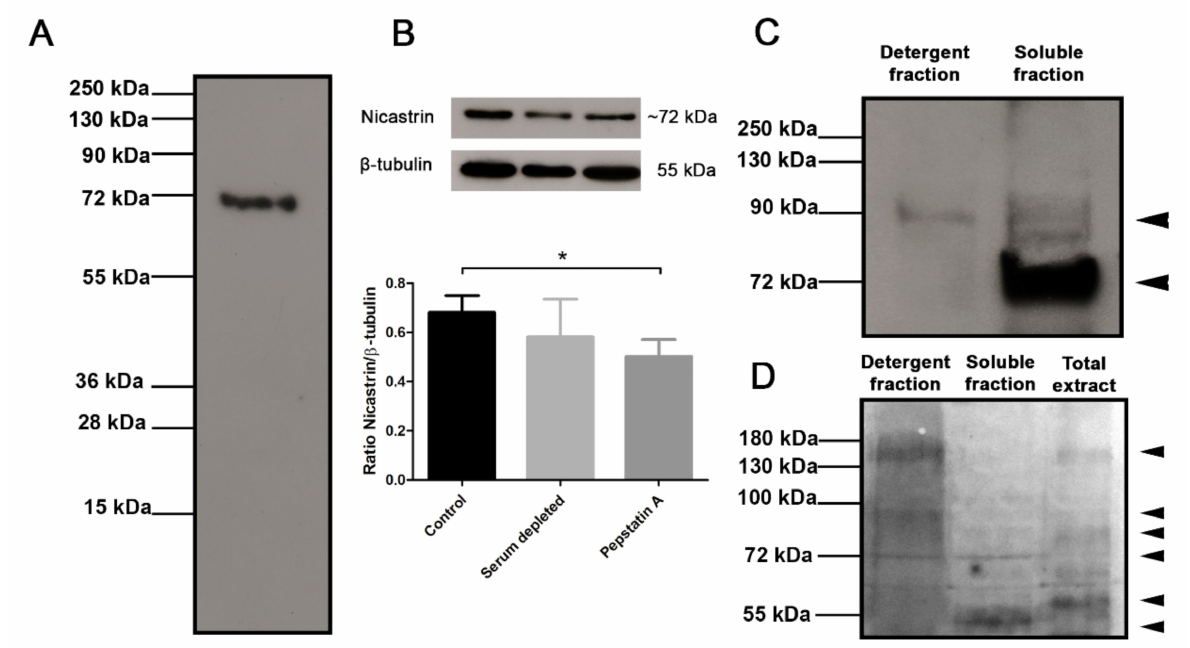
Figure 2. Immunoblot analysis of anti-Tc/NICT-1 rabbit polyclonal serum for detection of the T. cruzi nicastrin-like protein. ( A ) The whole extract (20 µ g) probed with anti-Tc/NICT-1 serum identified a band with ~72 kDa. ( B ) Whole-cell extracts (20 µ g) from epimastigotes cultured 24 h under serum deprivation (BHI medium without FBS) and after treatment with gamma-secretase inhibitor pepstatin A (50 µ g/mL) probed with polyclonal anti-Tc/NICT-1 serum or anti- β -tubulin antibodies (internal control). The corresponding densitometry presents the ratio of T. cruzi NICT-like protein and β -tubulin. Data represent the mean and standard deviation from at least three independent experiments. ( C ) Membrane enriched fraction and soluble proteins probed with anti-Tc/NICT-1. ( D ) Detection of glycoproteins in T. cruzi epimastigote extracts after SDS-PAGE separation of detergent fraction (20 µ g), the soluble fraction (20 µ g), and total extract (20 µ g). Stained bands were developed using a commercial kit (Immun-Blot ® Kit for glycoprotein detection (Bio-Rad)) and demonstrate glycosylated proteins in bands. Six different markedly bands (arrowheads) were observed in the detergent fraction (~150, ~95, and ~72 kDa), the soluble fraction (~72 and ~50 kDa), and epimastigote whole extract (~150, ~80, and ~60 kDa). * Significant difference using t -test ( p < 0.05) (for original blotting see Figure